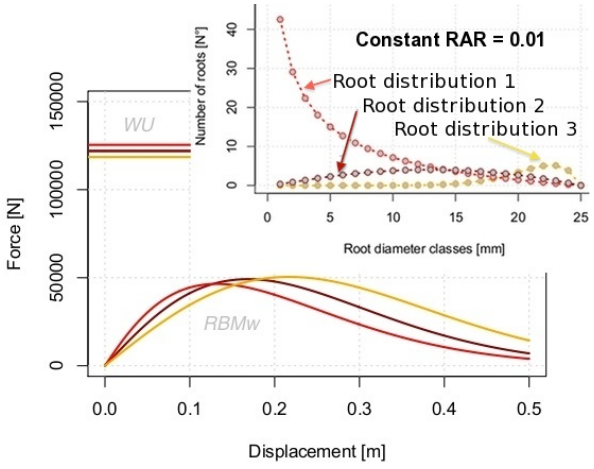
Fig. 7. Sensitivity analysis of the displacement-force curve of a bun- dle considering three different root distributions (see insert) with a constant root area ratio (RAR) equal to 0.01, calculated with the RBMw and the Wu model. All the geometric and mechanical pa- rameters were kept